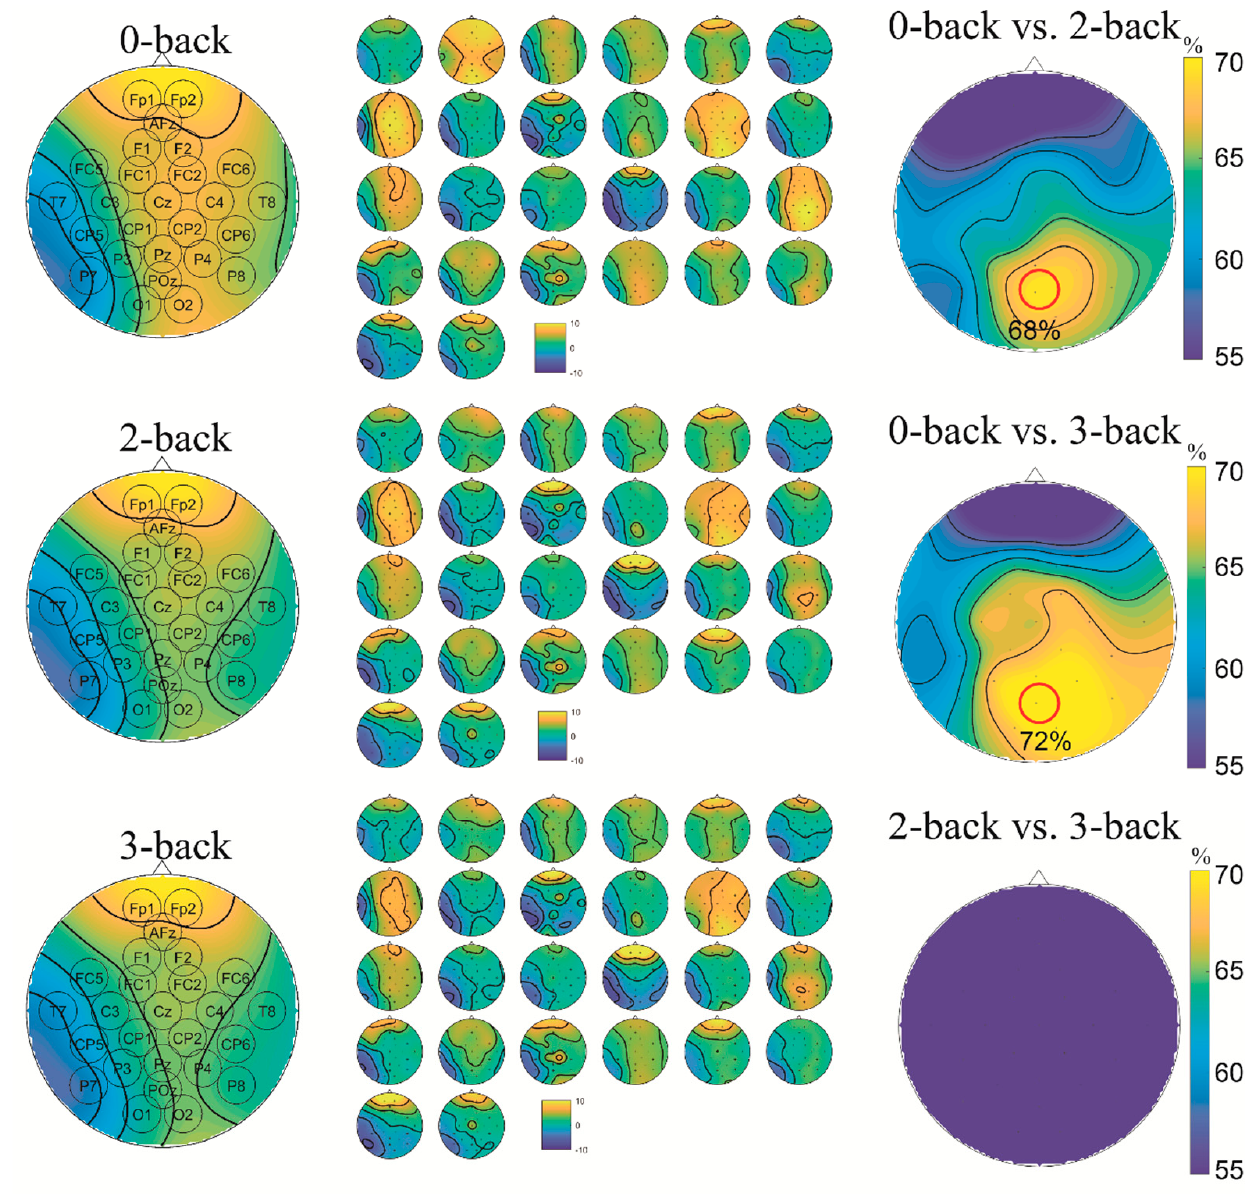
Figure 6. Topographic map of the EEG alpha-band PSD. Left: average; Middle: each participant; Right: Accuracy using each-channel PSD as the input. The area that provides the highest accuracy is highlighted.